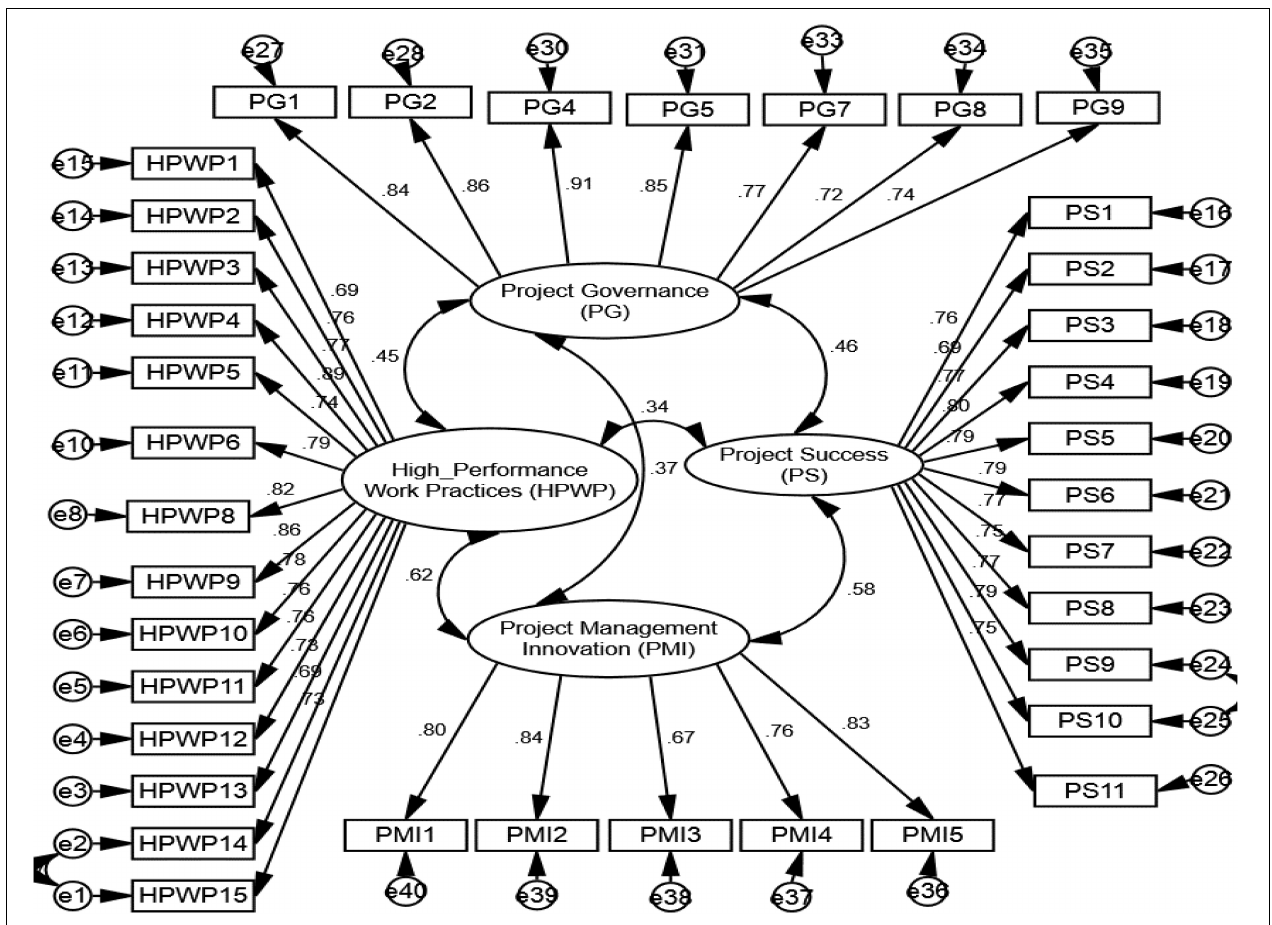
FIGURE 2 | Measurement model.